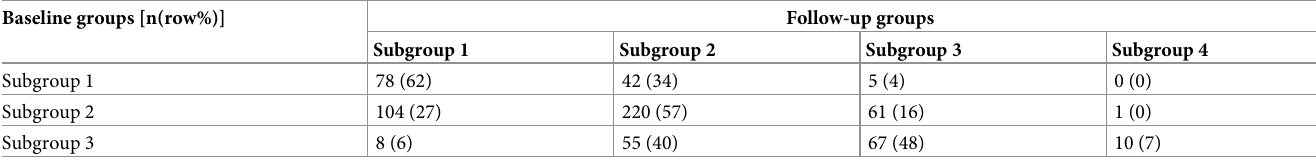
Table 4. Comparisons of subgroups identified at baseline and at